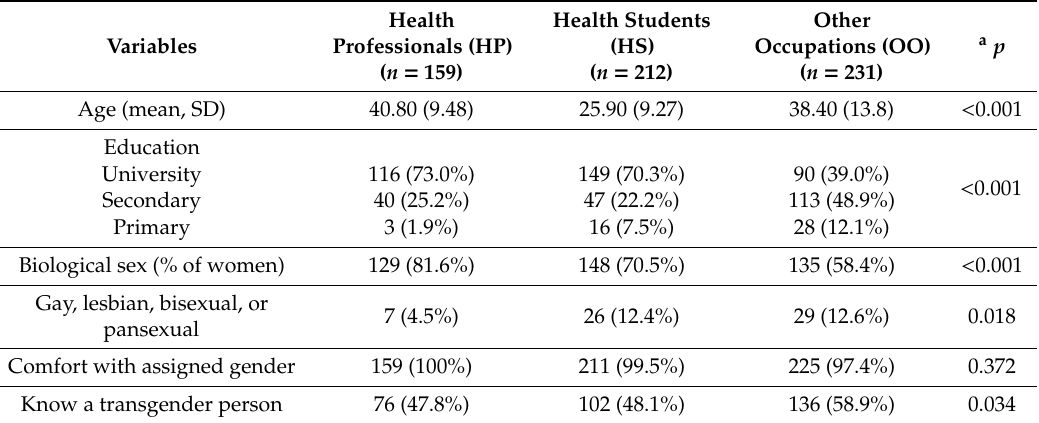
Table 1. Characteristics of the